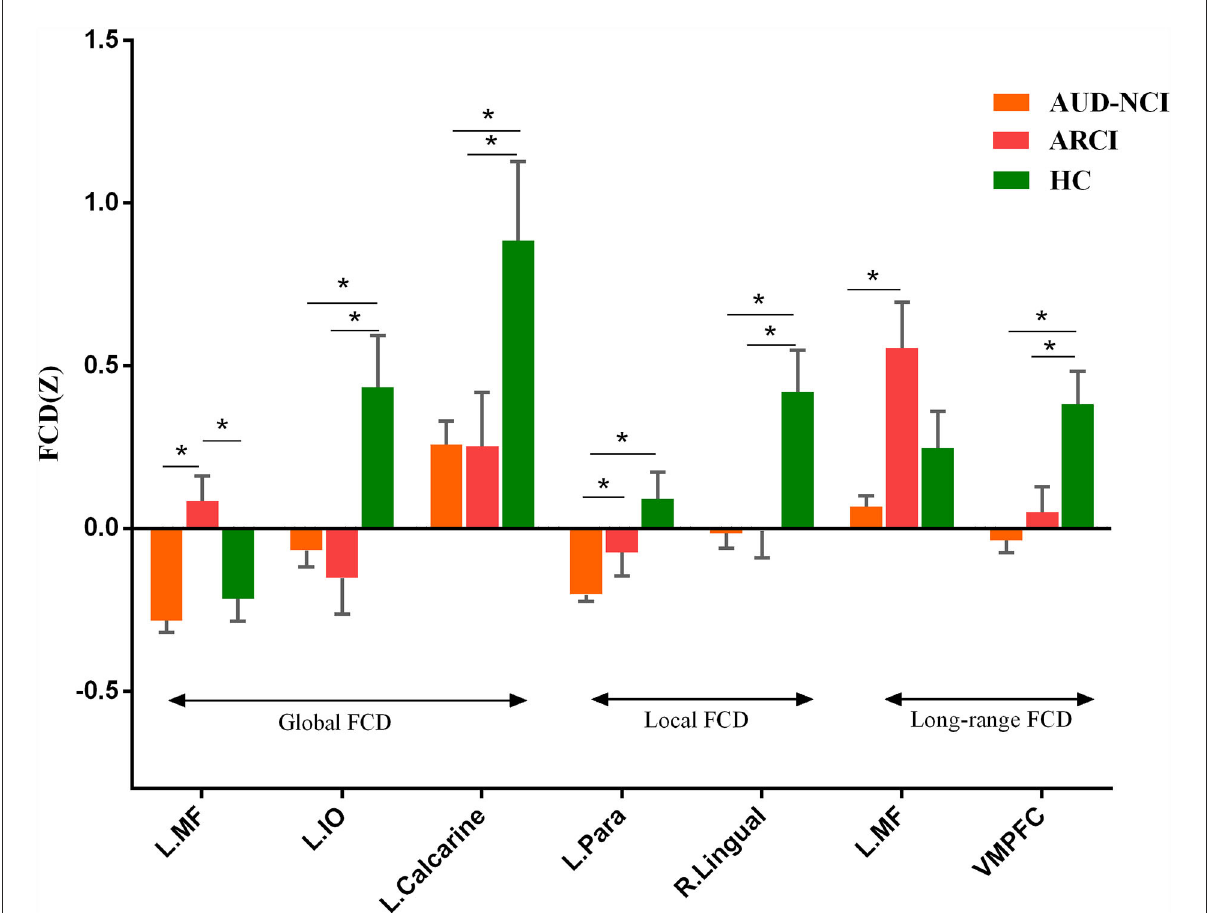
FIGURE2 Post-hoc analysis results. MF, medial frontal gyrus; IO, inferior occipital lobe; Para, parahippocampal gyrus; VMPFC, ventromedial frontal gyrus.